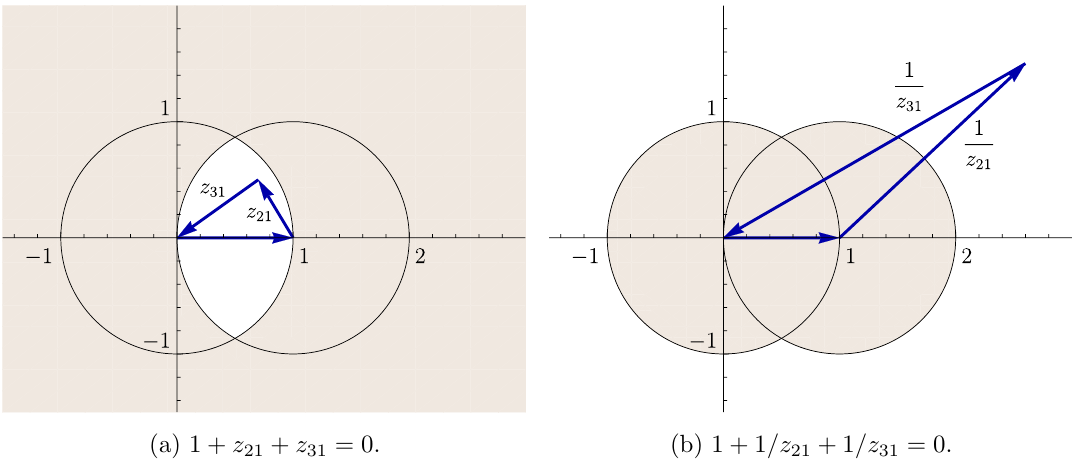
Figure 7. The space of non-standard N = 3 solutions in the low-temperature limit with identical chemical potentials ~(cid:1) a = 1 = 3. Solutions of the (cid:12)rst type, satisfying 1 + z 21 + z 31 = 0, are shown in (a), while solutions of the second type, satisfying 1 + 1 =z 21 + 1 =z 31 = 0, are shown in